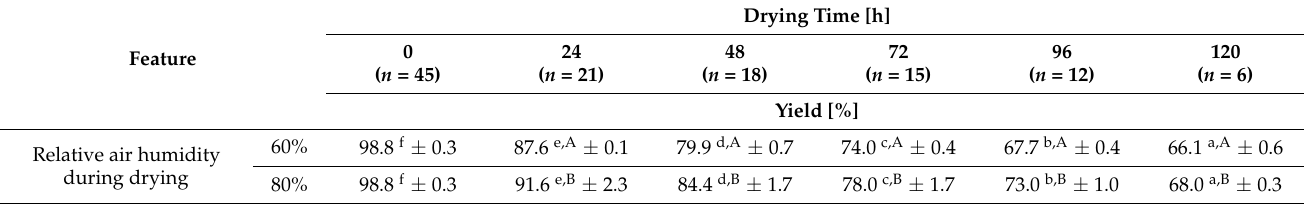
Table 2. Yield of KSS sausages (mean ± standard